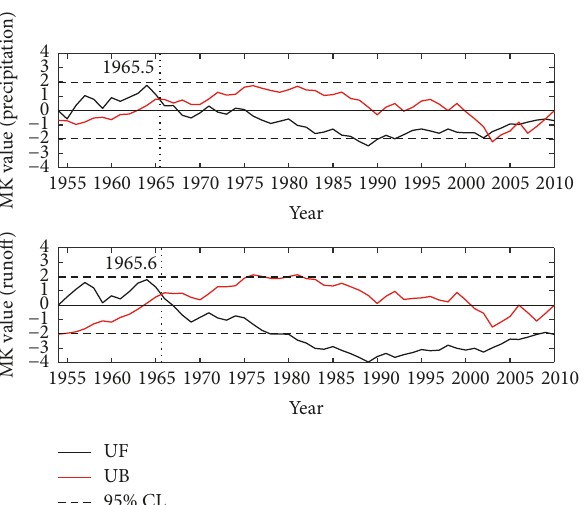
Figure 4: MK test of meteor-hydrological series of the Yi River Basin. The dashed lines denote 95% confidence level.